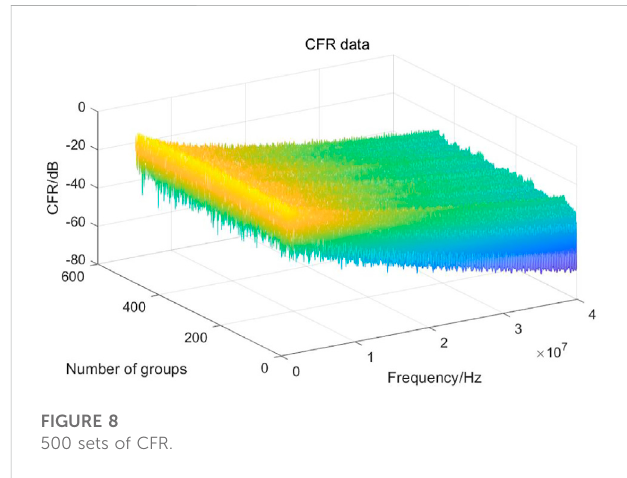
FIGURE 8 500 sets of